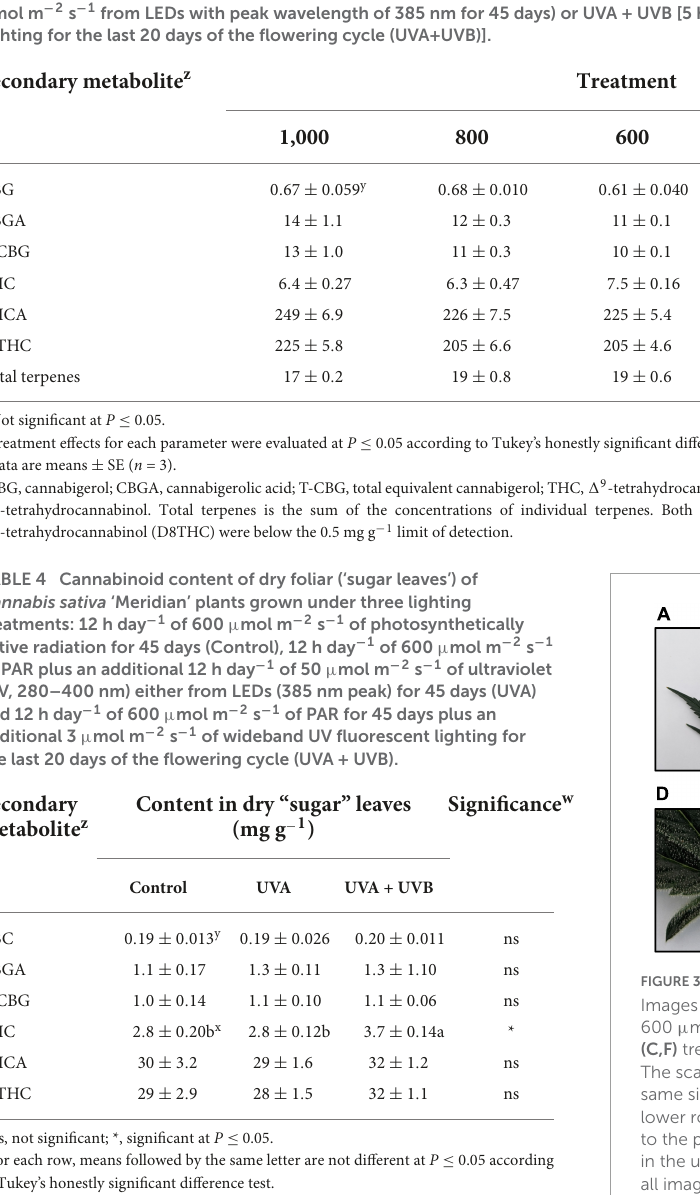
TABLE 3 Cannabinoid and total terpene content (mg g − 1 ) of dry composite inflorescence samples of Cannabis sativa ‘Meridian’ plants grown under light emitting diodes (LEDs) for 45 days with average canopy-level photosynthetic photon densities (PPFD) of either 600, 800, or 1,000 µ mol m − 2 s − 1 for 12 h day − 1 or PPFD of 600 µ mol m − 2 s − 1 plus ultraviolet (UV, 280–400 nm) from either UVA (12 h day − 1 of 50 µ mol m − 2 s − 1 from LEDs with peak wavelength of 385 nm for 45 days) or UVA + UVB [5 h day − 1 of 3 µ mol m − 2 s − 1 of wideband UV fluorescent lighting for the last 20 days of the flowering cycle (UVA+UVB)].